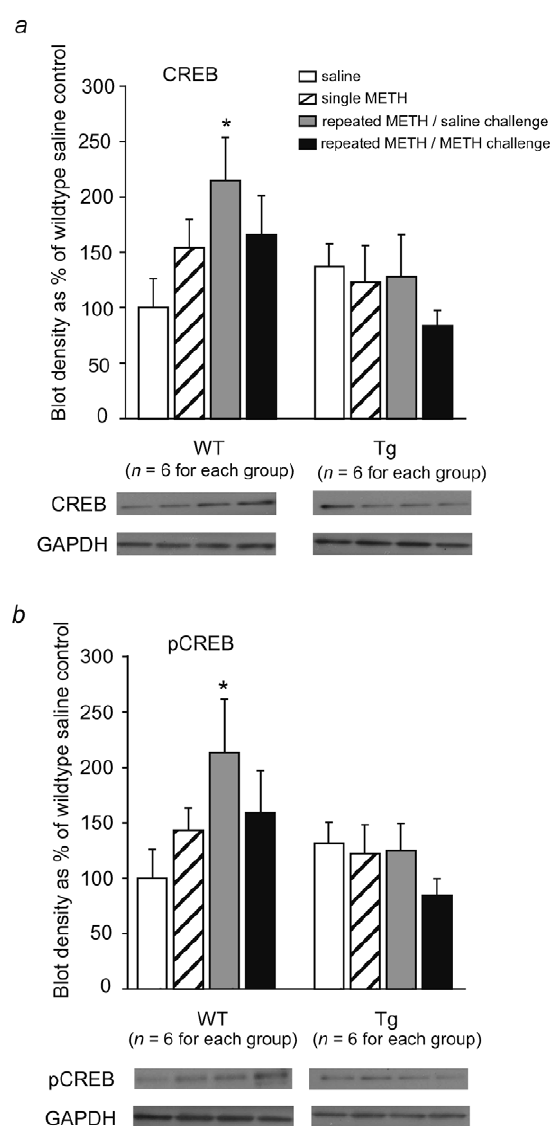
Figure 3. CREB expression and phosphorylation in the CPu after single and repeated METH treatment. The mice were administered METH (1 mg/kg, i.p.) or saline once or received METH (1 mg/kg, i.p.) once every other day from Day 1 to Day 13 and challenged with saline or METH (1 mg/kg, i.p.) on Day 20 after a 7 day drug-free period. The mice were decapitated 1 h after the last METH or saline treatment. The blot density of each group was normalized to that of the wildtype saline group and is expressed as mean 6 SEM ( n =6). a . METH-induced CREB expression in the CPu in wildtype mice (WT) and ICER I-overexpressing mice (Tg). * p , 0.05, significant difference in normalized CREB blot density compared with wildtype saline group. b . METH-induced CREB phosphorylation in the CPu in wildtype mice (WT) and ICER I-overexpressing mice (Tg). * p , 0.05, significant difference in normalized pCREB blot density compared with wildtype saline